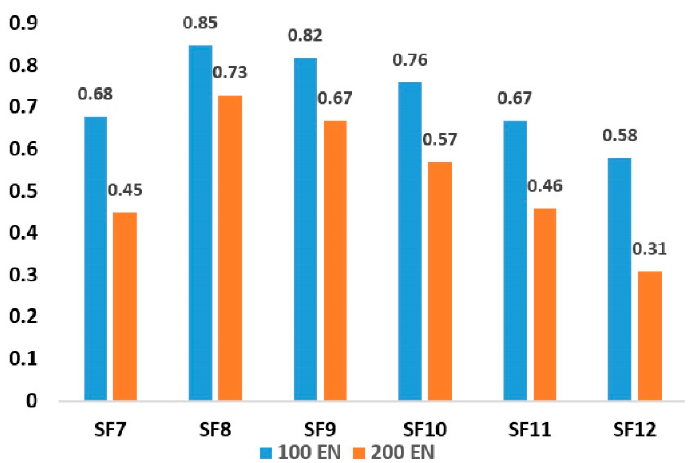
Figure 6. Successful transmission for a gateway.